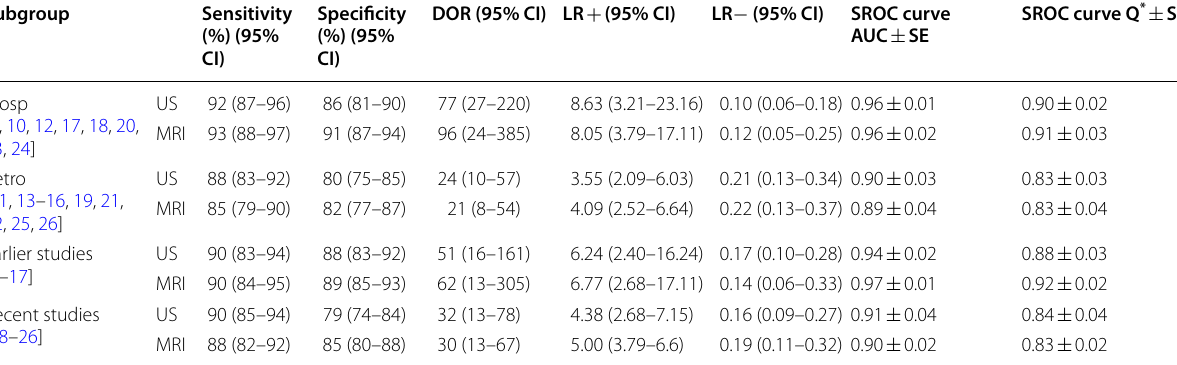
US, ultrasonography; MRI, magnetic resonance imaging; PAS, placenta accrete spectrum disorder; DOR, diagnostic odds ratio; LR negative likelihood ratios; SROC, summary receiver operating characteristic; AUC, area under the SROC curve; SE, standard error